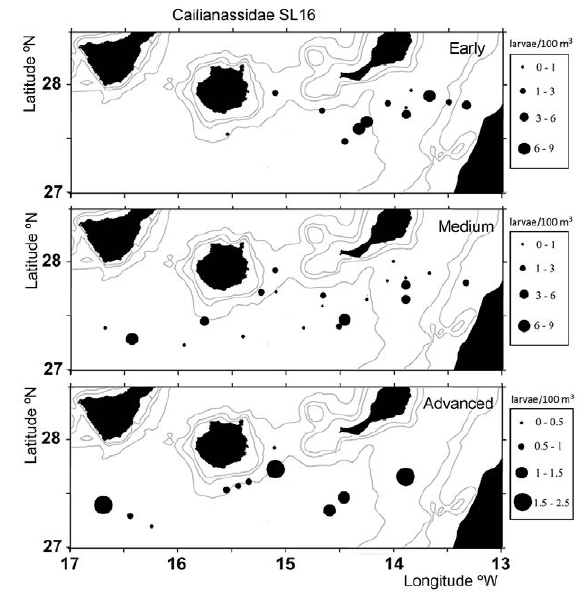
Fig. 6. – Horizontal distribution of the abundance of the Callianassi- dae SL16 larvae in early, medium and advanced stage of develop- ment. Symbol size represents densities (larvae/100 m 3 ), as indicated in the